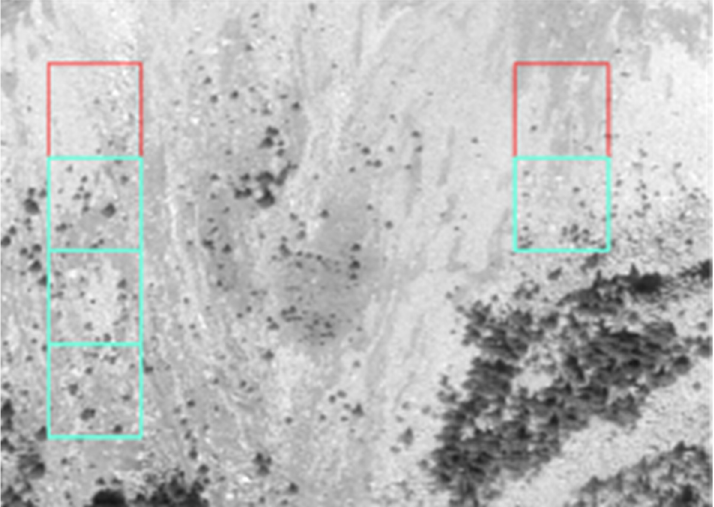
Figure 17. Disagreement between the CNNs and visual image interpretation. Blue-green image patches correspond to agreement for the class “group of trees”. Red image patches correspond to disagreement, i.e., classification as “other” and interpretation as “group of trees”.